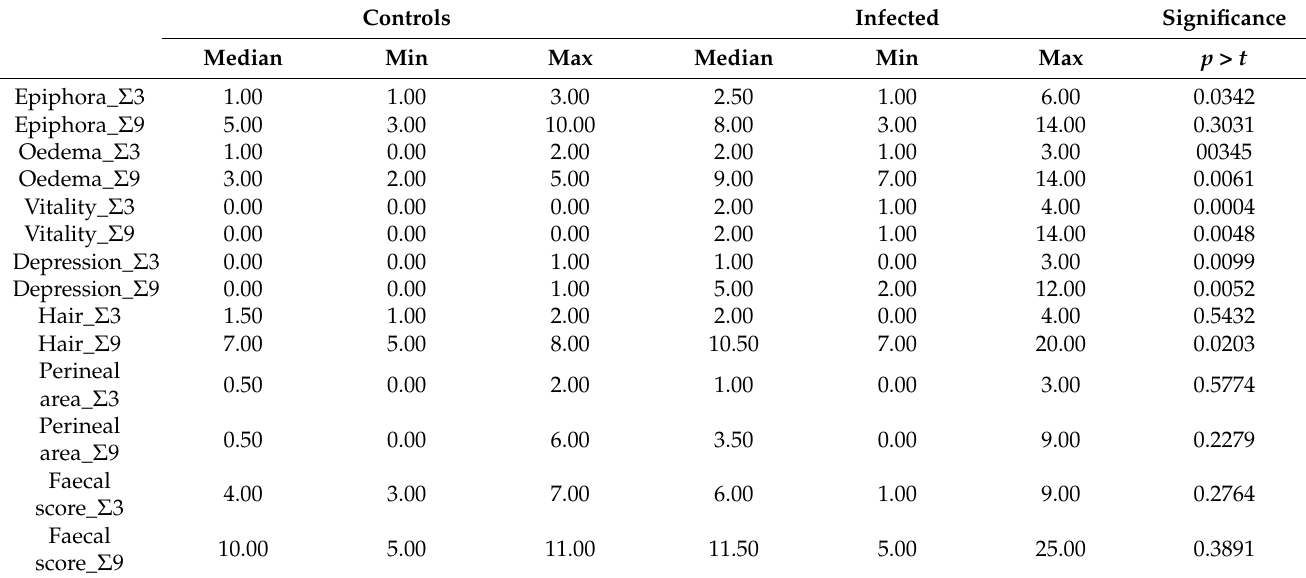
Table 3. Total median scores related to clinical symptoms. Controls